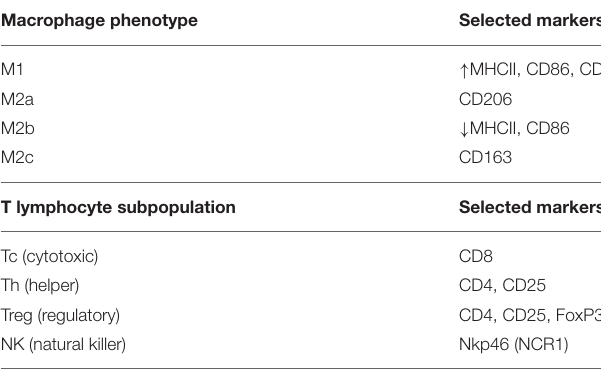
TABLE 2 | List of antibodies and corresponding dilutions used in immunohistochemical staining. Target protein